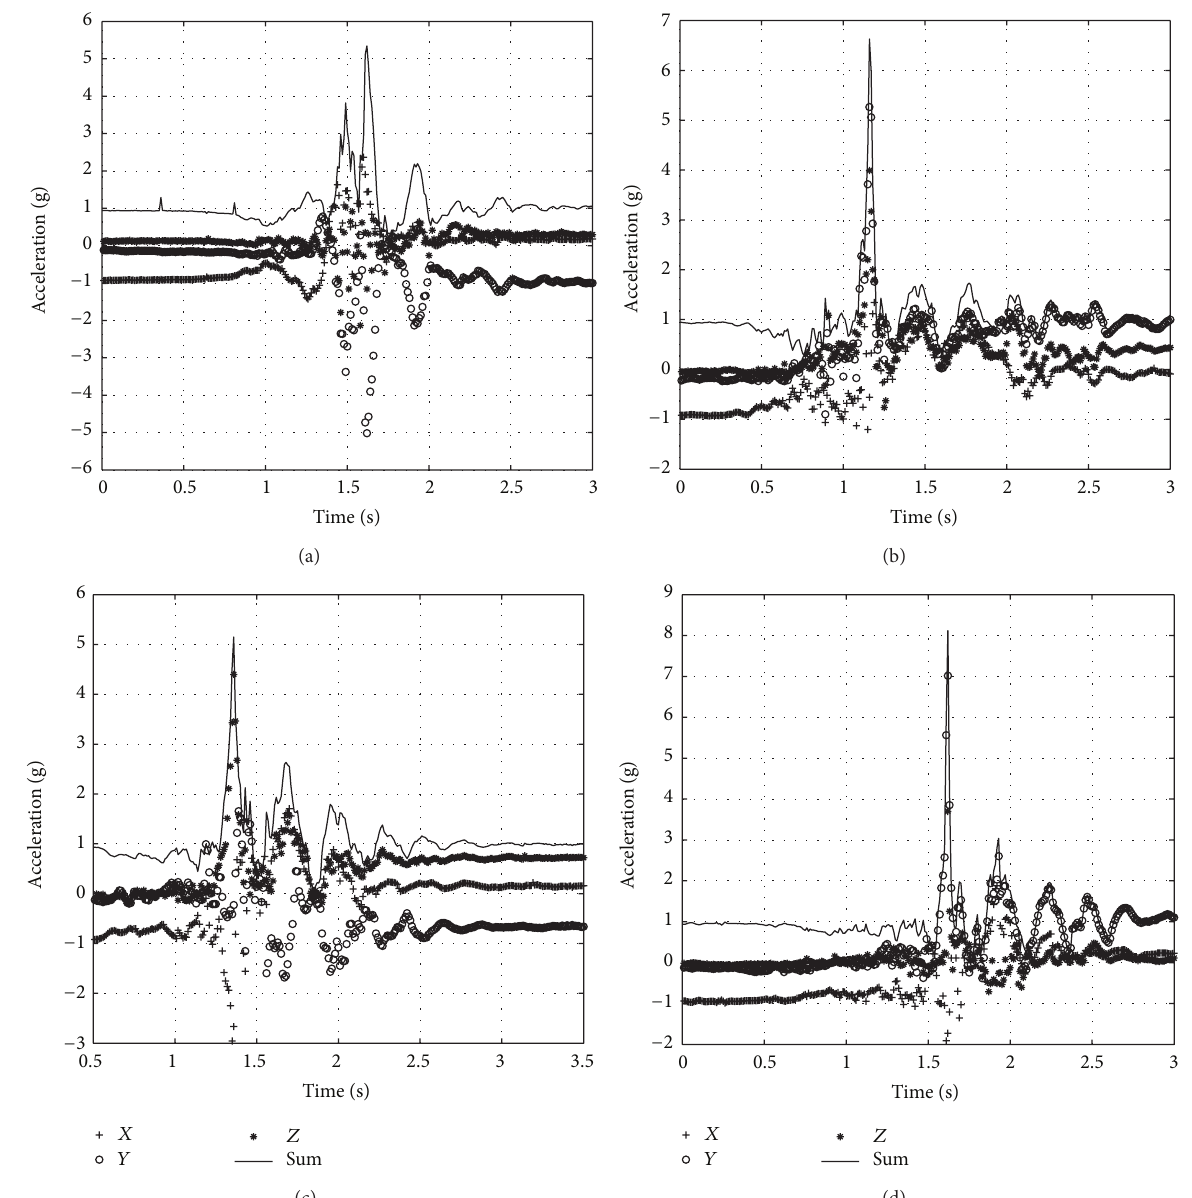
Figure 9: Acceleration waveforms during fall. (a) Forward fall. (b) Backward fall. (c) Leftward fall. (d) Rightward fall.